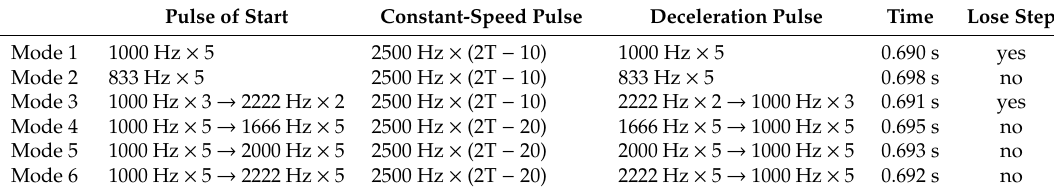
Table 10. Pulse mode in the second control